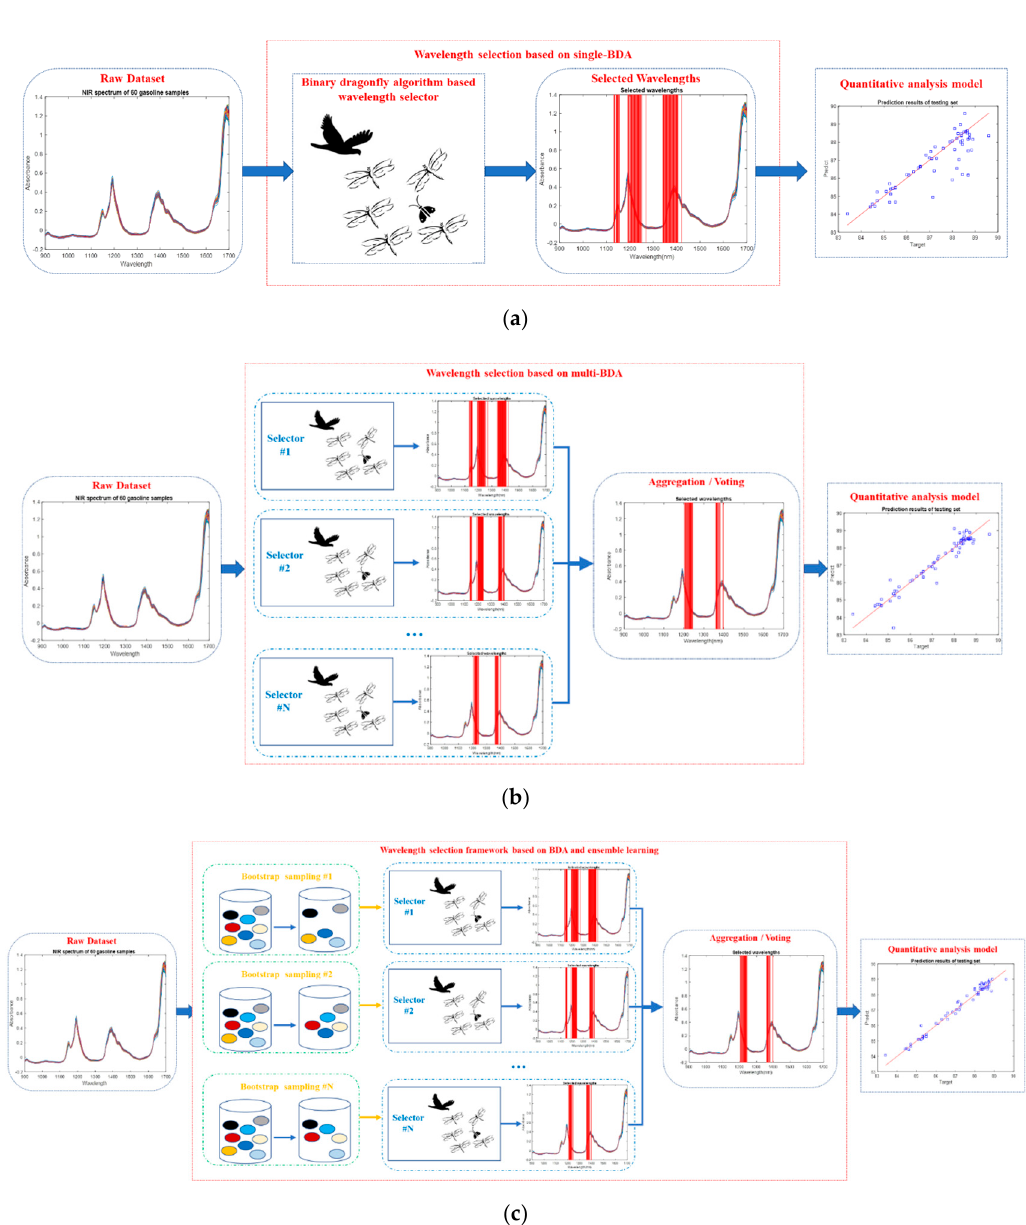
Figure 3. Three typical wavelength selection methods based on BDA. ( a ) Wavelength selection based on the single-BDA method; ( b ) wavelength selection based on the multi-BDA method; ( c ) wavelength selection framework based on the BDA and ensemble learning method.